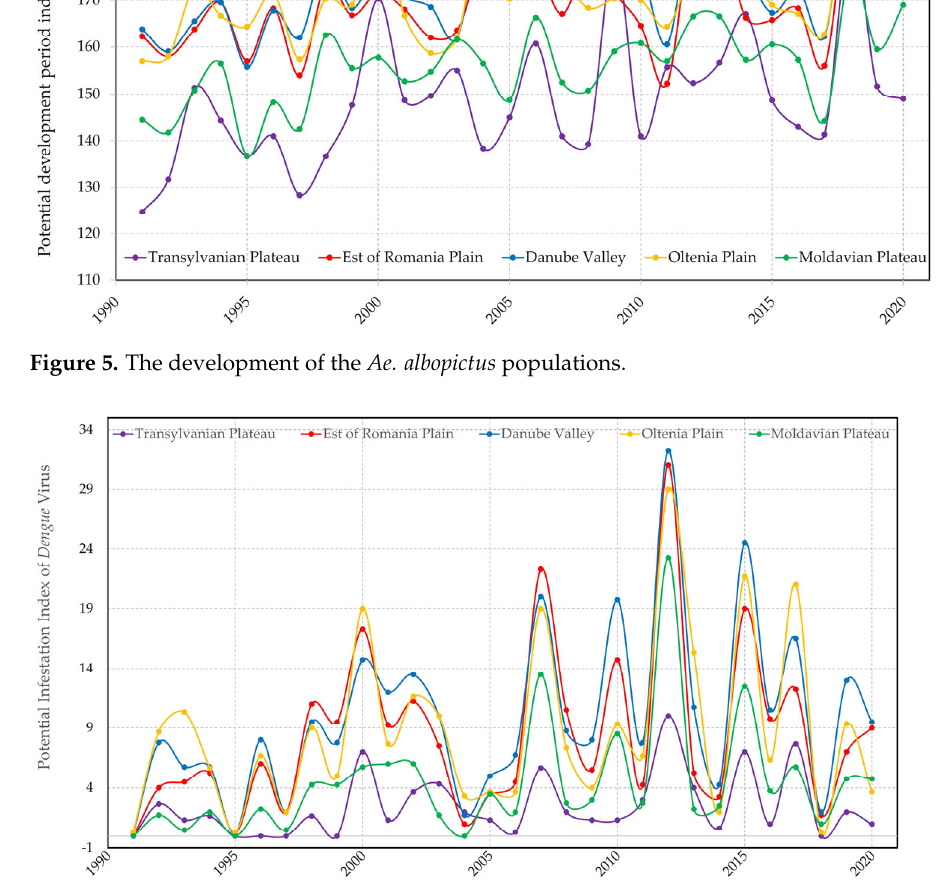
Figure 5. The development of the Ae. albopictus populations.